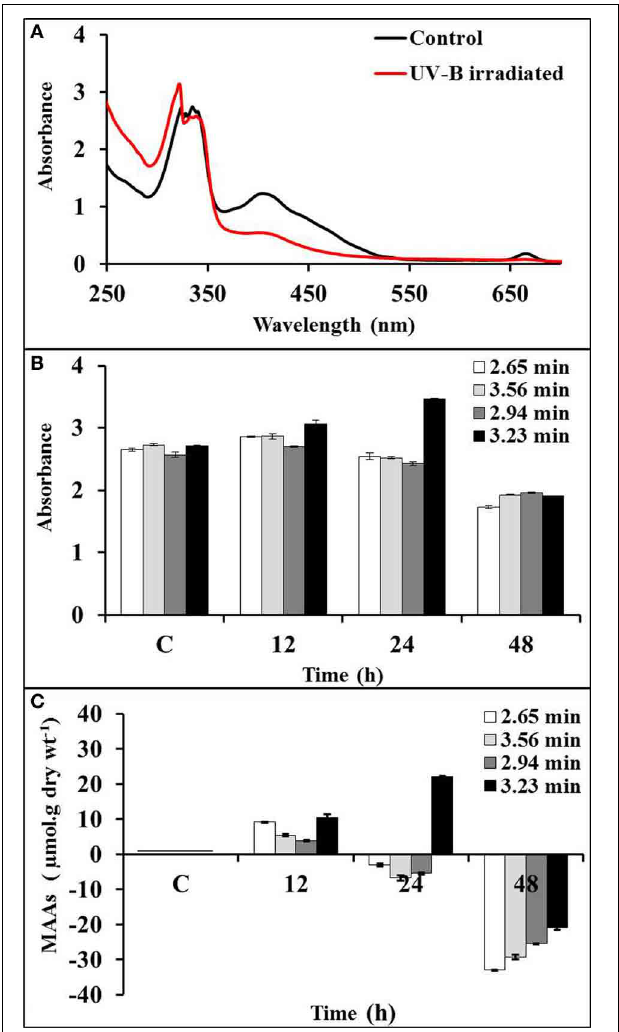
FIGURE 3 | Absorption spectra of control and UV-B irradiated Bryocladia sp. extracts (A) and showing relative induction of MAAs at retention times 2.65 ( λ max 340nm), 2.94 ( λ max 328nm), 3.56 ( λ max 335nm), and 3.23min ( λ max 323nm) after 12, 24, and 48h of UV-B irradiation (B). Actual percentage induction/reduction of MAAs (C) .